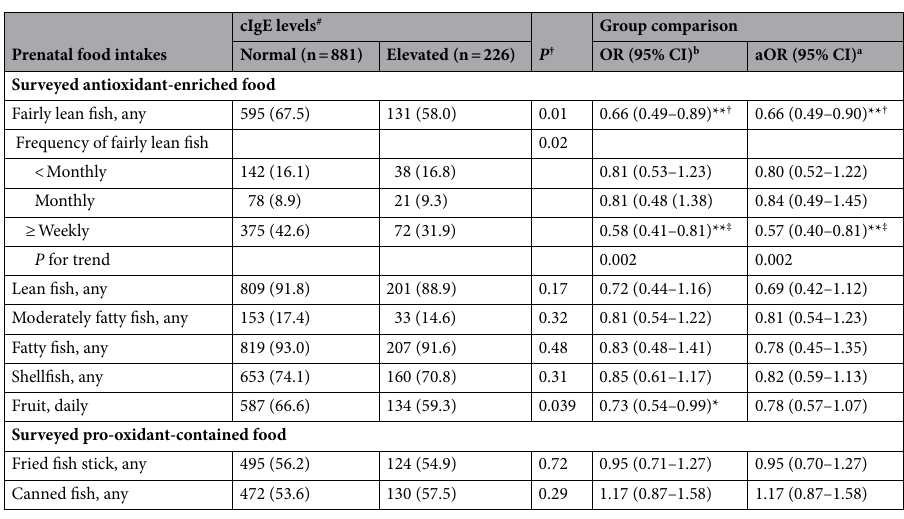
Table 2. Distributions of prenatal surveyed antioxidant-enriched and pro-oxidant-contained food consumption by and their associations with cord blood total IgE (cIgE) elevation in the study sample (N = 1107). cIgE, cord blood total IgE; OR, odds ratio; aOR, adjusted odds ratio; 95% CI, 95% confidence interval. # Values are presented as n (%). † Chi-square test. * P < 0.05, ** P < 0.01, † P < 0.05 after FDR